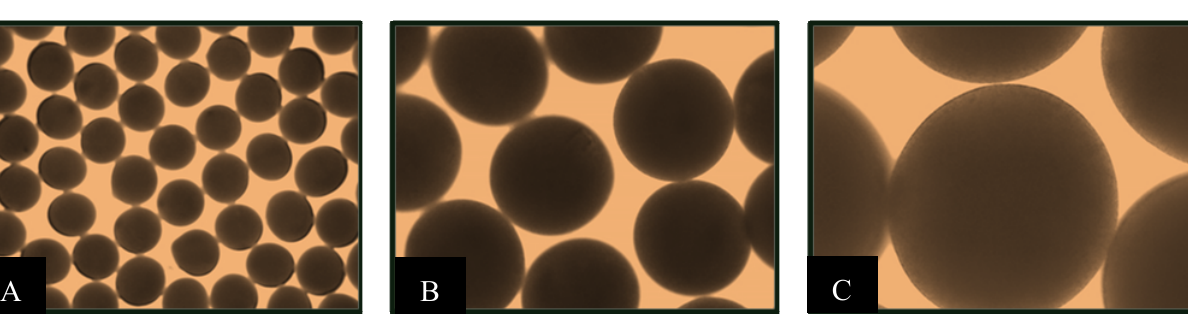
Figure 2 . Morphology of APA microcapsule containing L. fermentum NCIMB 5221 taken by light microscope ( A ) 40× ( B ) 100× ( C ) 200×. The approximate diameter of the microcapsules was 400 ± 25 μ